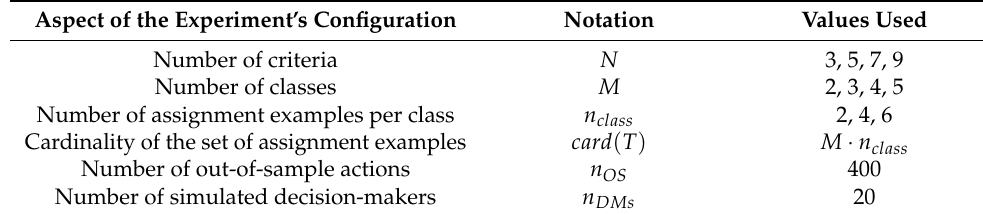
Table 1. Configurations of the